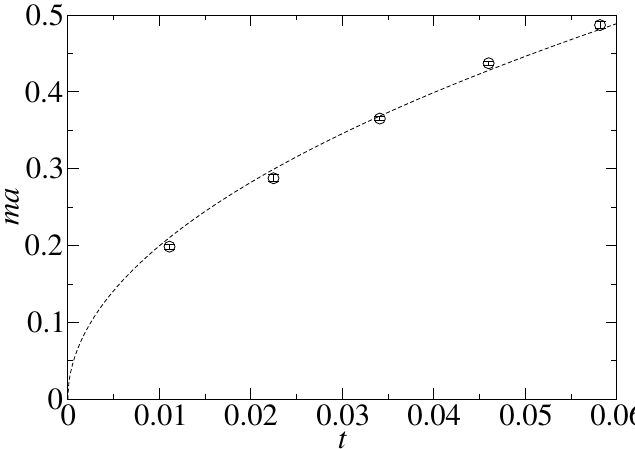
Figure 2 . Mass values in units of the inverse lattice spacing at different reduced temperatures, extrapolated to the thermodynamic limit (circles), and their fit according to eq. (3.2) (dashed